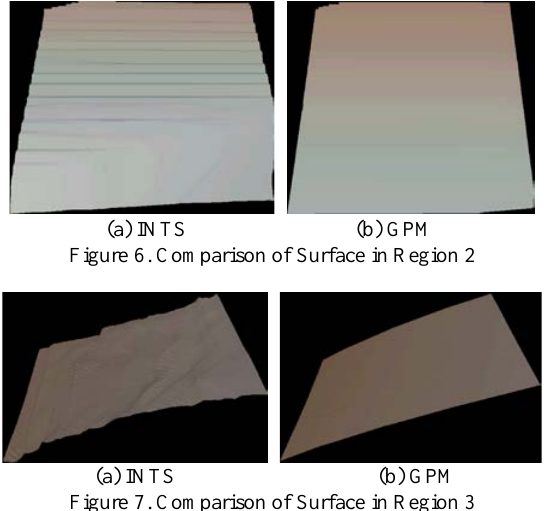
Figure 7. Comparison of Surface in Region 3